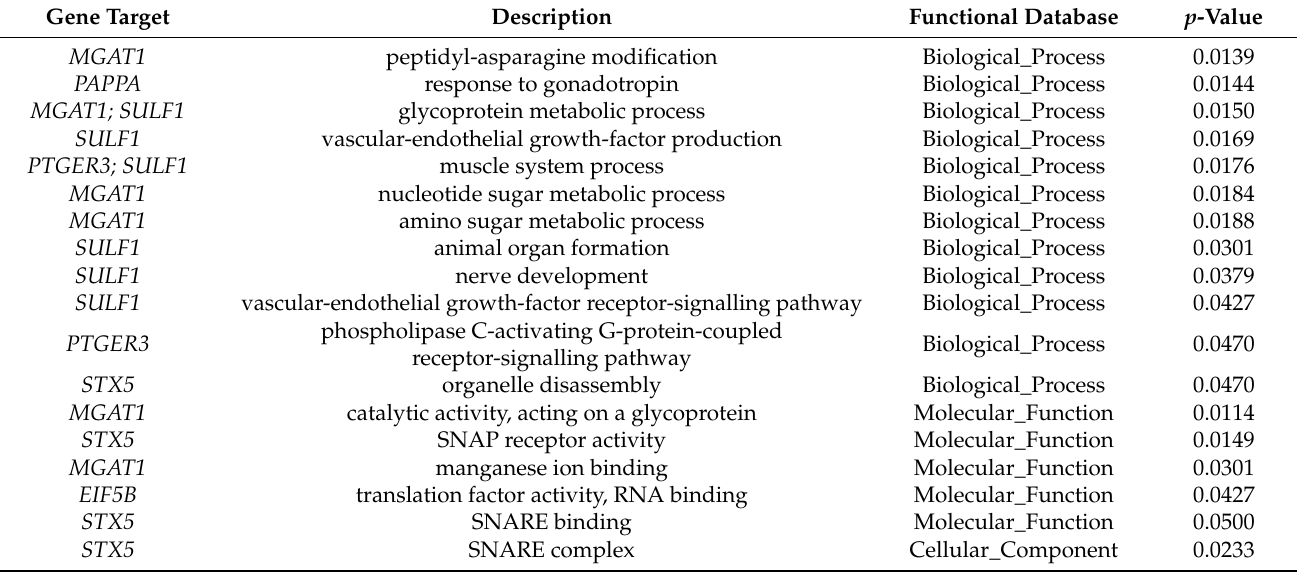
Table 4. Gene ontology analysis for the eight most significantly dysregulated proteins.